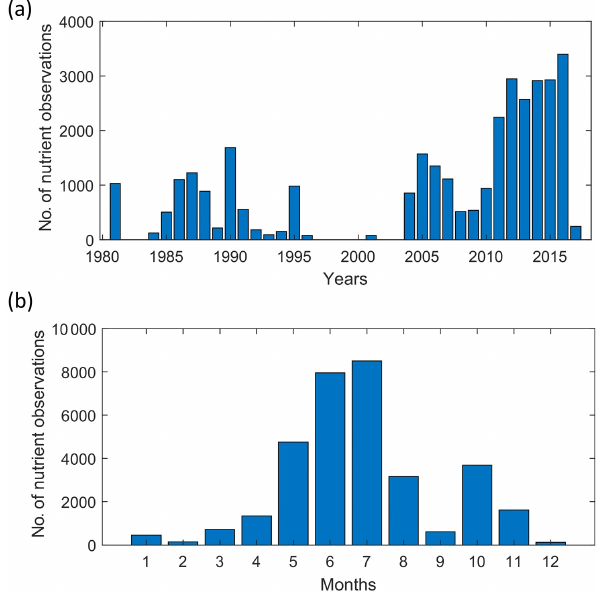
Figure 2. Temporal distribution of nutrient observations used for producing the BGC-WMED fields (1981–2017), (a) yearly distri- bution and (b) monthly